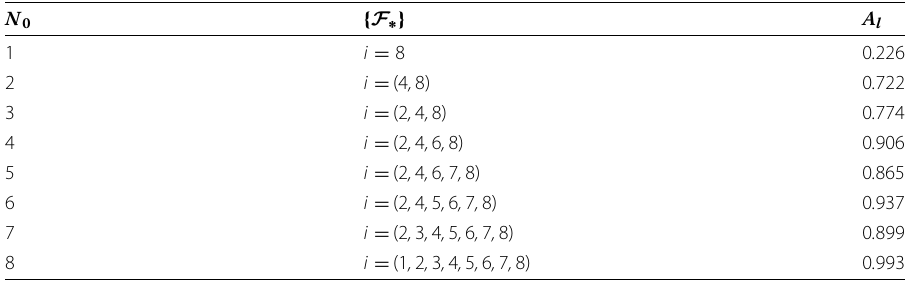
Table 7 Damage localization, case